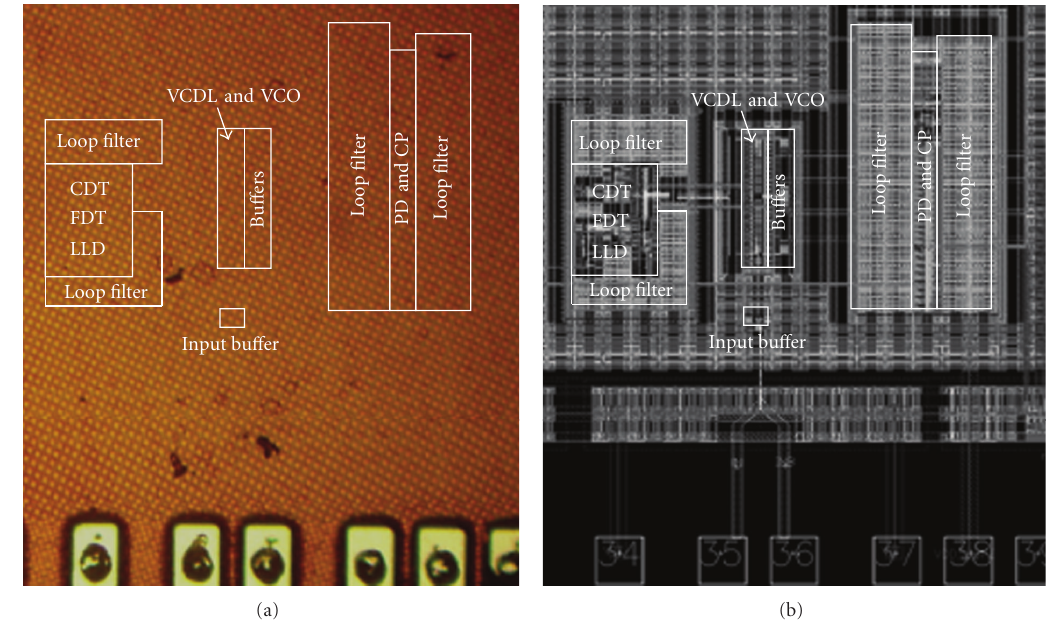
Figure 7: Photomicrograph and layout of the test chip.